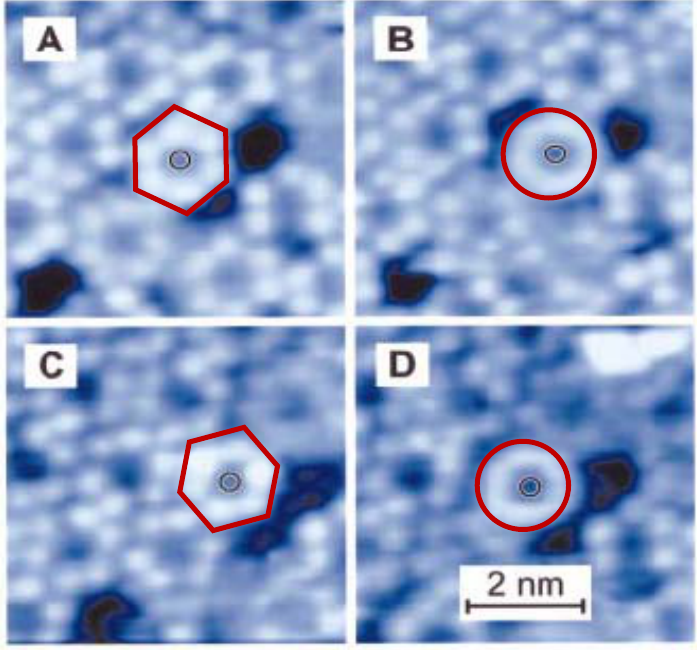
Figure 3. Sequence of STM images of an atomically clean Cu(100) surface after exposure to a coverage just below one complete monolayer of HB-DC measured in UHV at room temperature. In ( A ) and ( C ), the same molecule is translated by 0.26 nm and imaged as a six-lobed structure in registry with the surrounding molecular layer. Image area is 5.75 nm by 5.75 nm, recorded with a tunnel voltage of V = 0.35 V and a tunnel current of t i = 90 pA [78]. In ( B ) and ( D ) the molecule is imaged as a torus and is in a location where t it is not in phase with the overall 2D molecular overlayer (disengaged